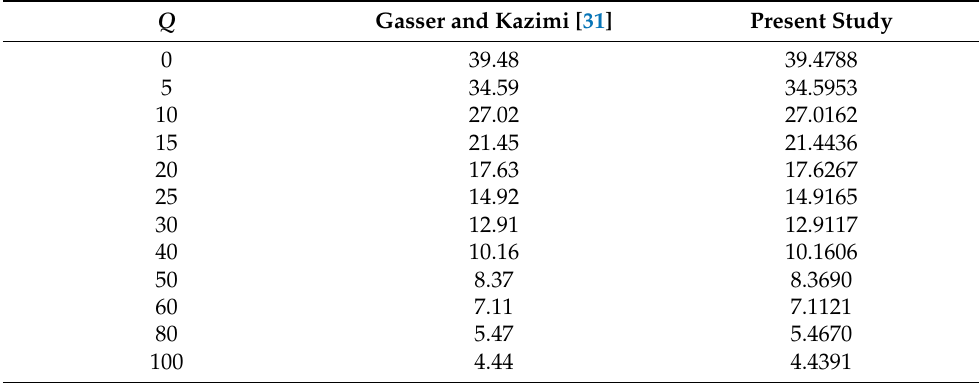
Table 1. Critical Rayleigh number values for Ta = 0; Da = 0 and Pe = 0 compared with [31]. Q Gasser and Kazimi [31] Present Study